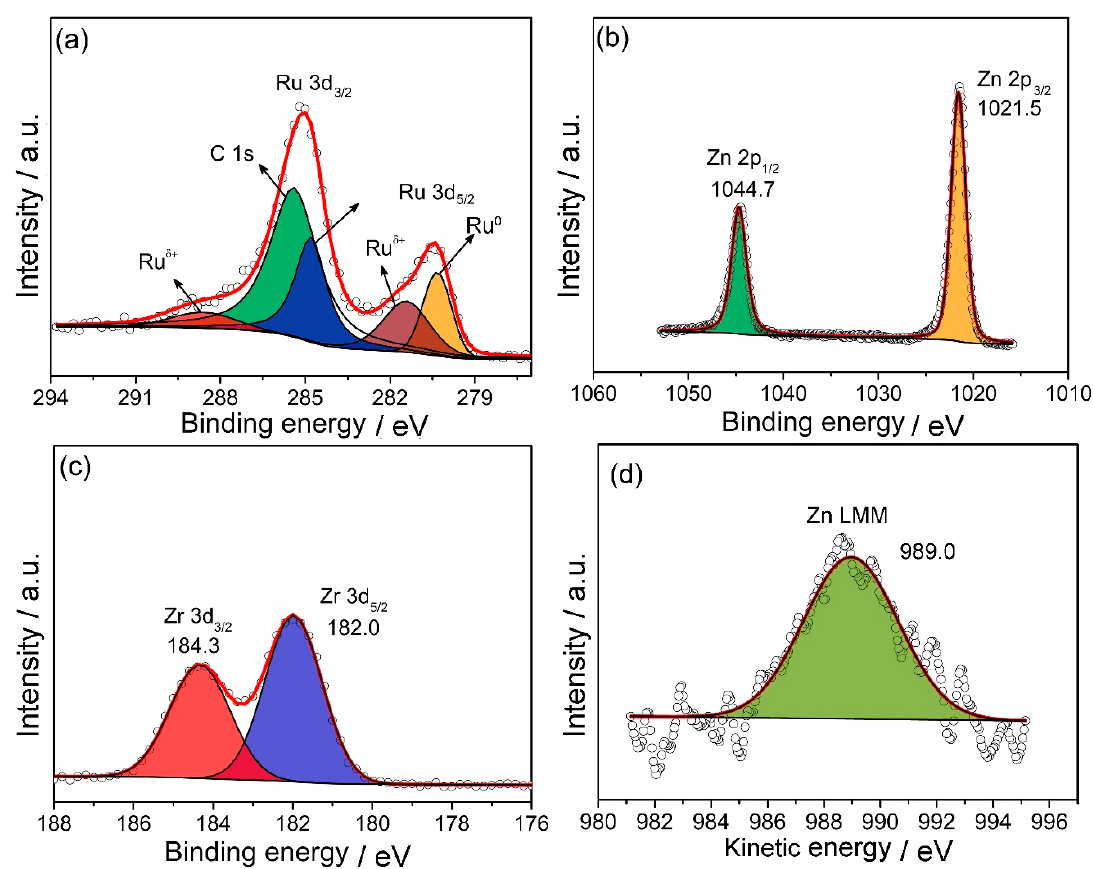
Figure 10. XPS profiles of the unsupported Ru-Zn (0.60) catalyst with m-ZrO 2 as the dispersant after catalytic experiments. ( a ) Ru3d 3/2 and Ru3d 5/2 ; ( b ) Zn2p 1/2 and Zn2p 3/2 ; ( c ) Zr3d 3/2 and Zr3d 5/2 ; ( d ) Zn LMM.